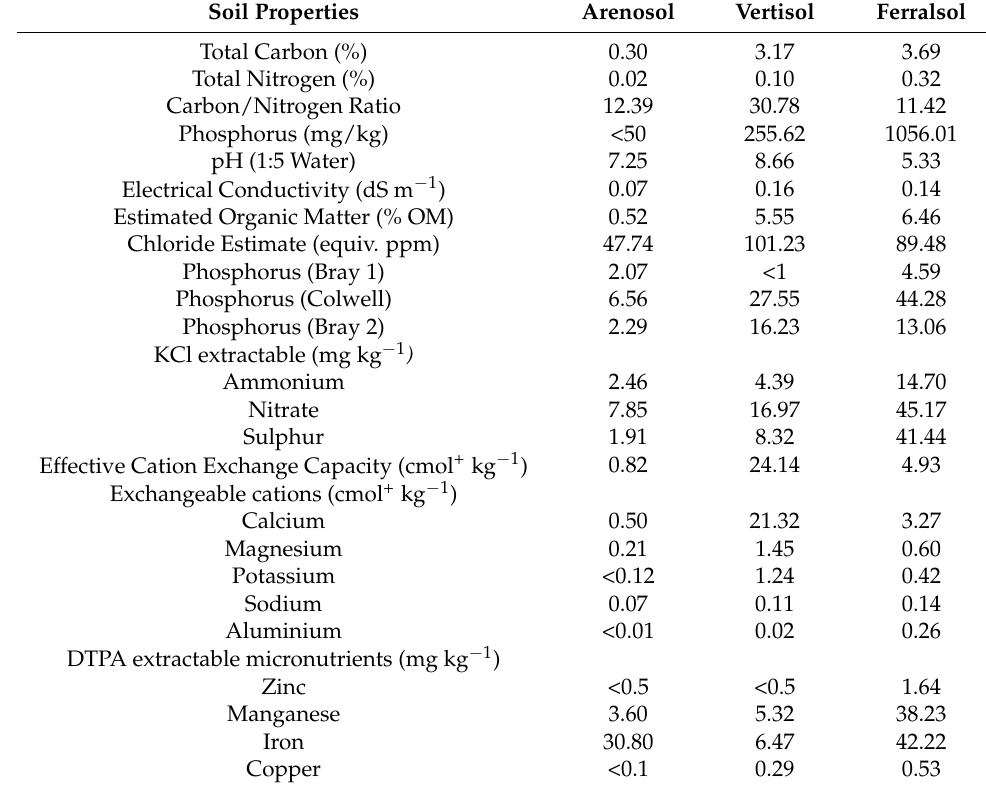
Table 2. Characterisation of soils used in P-limiting plant